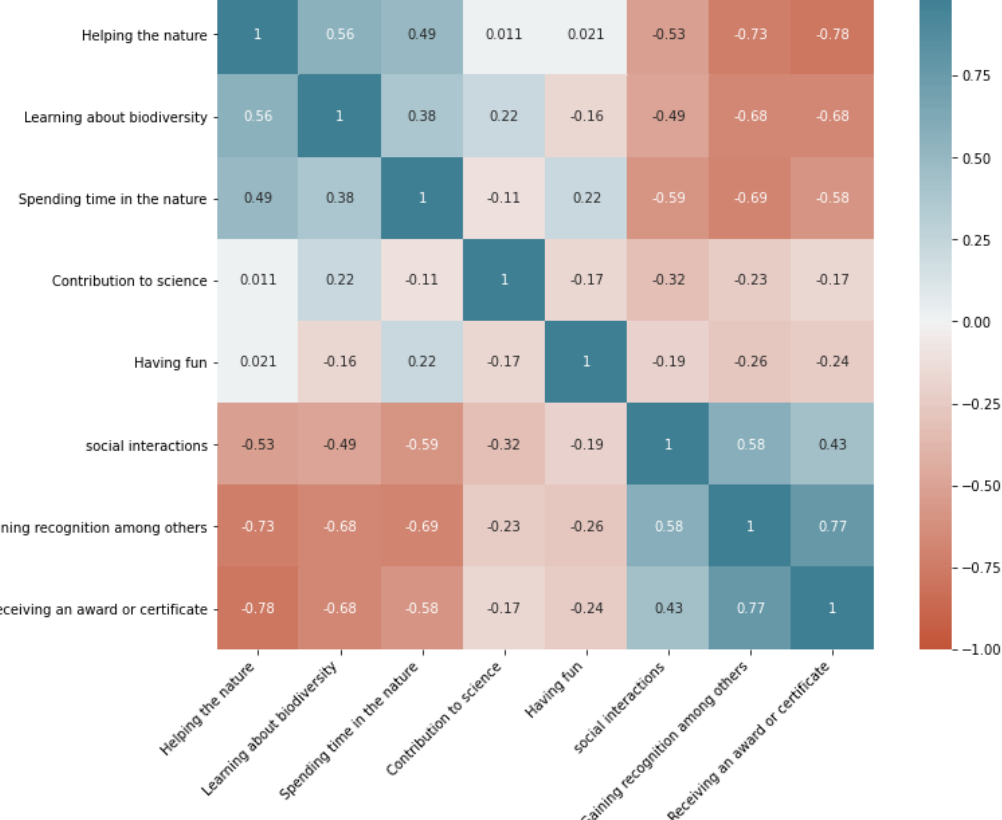
Figure 8. Motivation ranking to participate to BioPocket project [83]. Motivating factors were given scores from 1 to 8, and the ranking was based on the average score give to each.